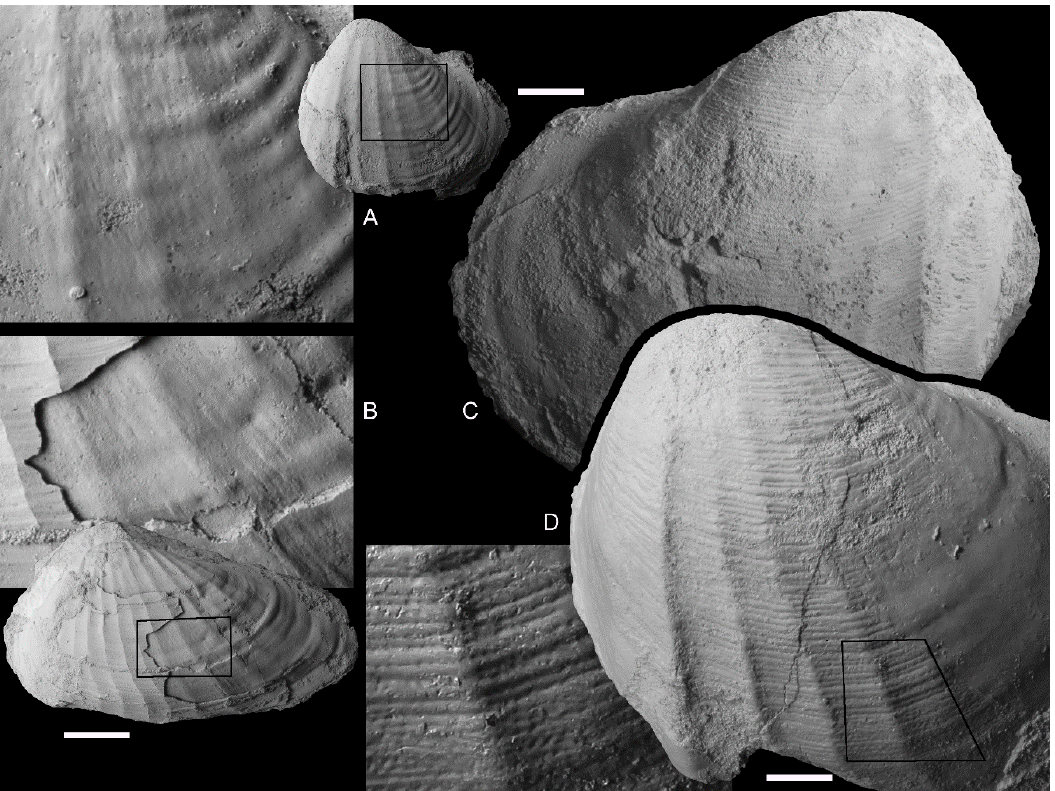
Figure 3. Internal relief. ( A , B ), Delicate, short radial ridges. ( A ), Pholadomya protei , Callovian, Bol ę cin (MGUS.Sz.3751), ( B ), Ph. latirostris , Lower Bathonian, Korwinów (specimen MGUS.Sz.3904). ( C ), Concentric ridges. Ph. bucardium , Callovian, Bol ę cin (MGUS.Sz.3920). ( D ), Wrinkled concentric ridges. Ph. bucardium , Callovian, Bol ę cin (MGUS.Sz.3755).